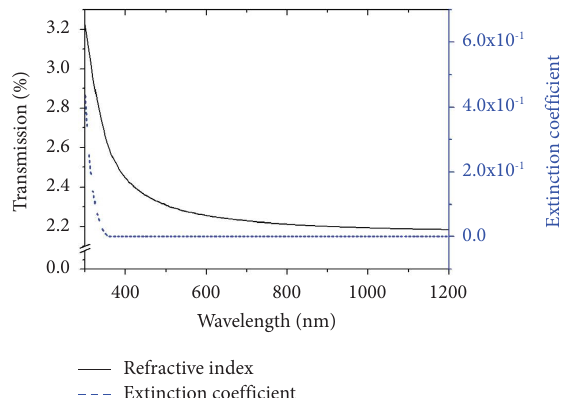
Figure 1: Calculated optical properties of sputtered Nb